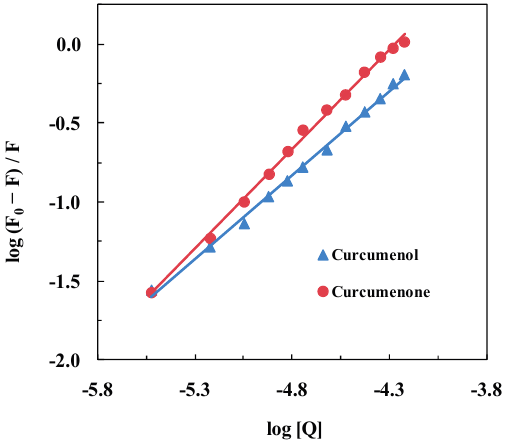
Figure 4. Double logarithmic plots for the interaction of HSA with curcumenol and